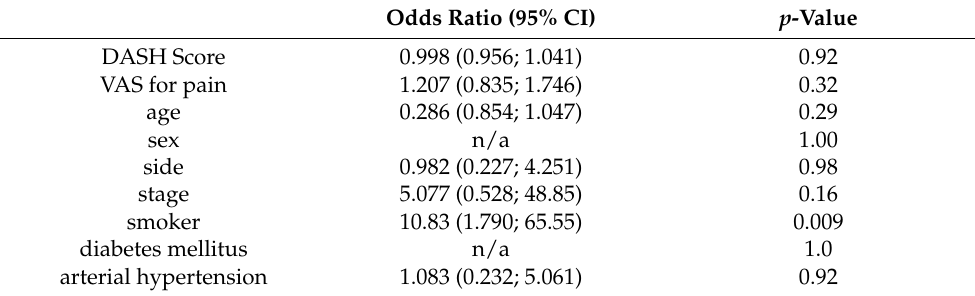
Figure 1. Kaplan–Meier plot indicating the cases requiring surgical conversion, resulting in a cumu- lative treatment response rate function. Table 1. Odds ratios and significance level for surgical conversion.